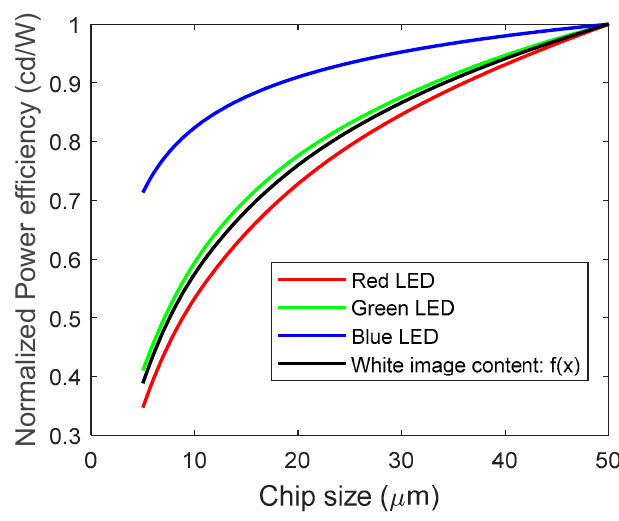
Figure 10. Chip size-dependent power efficiency of RGB micro-LED display. Table 2. The specifications of smartphone, laptop and TV evaluated.